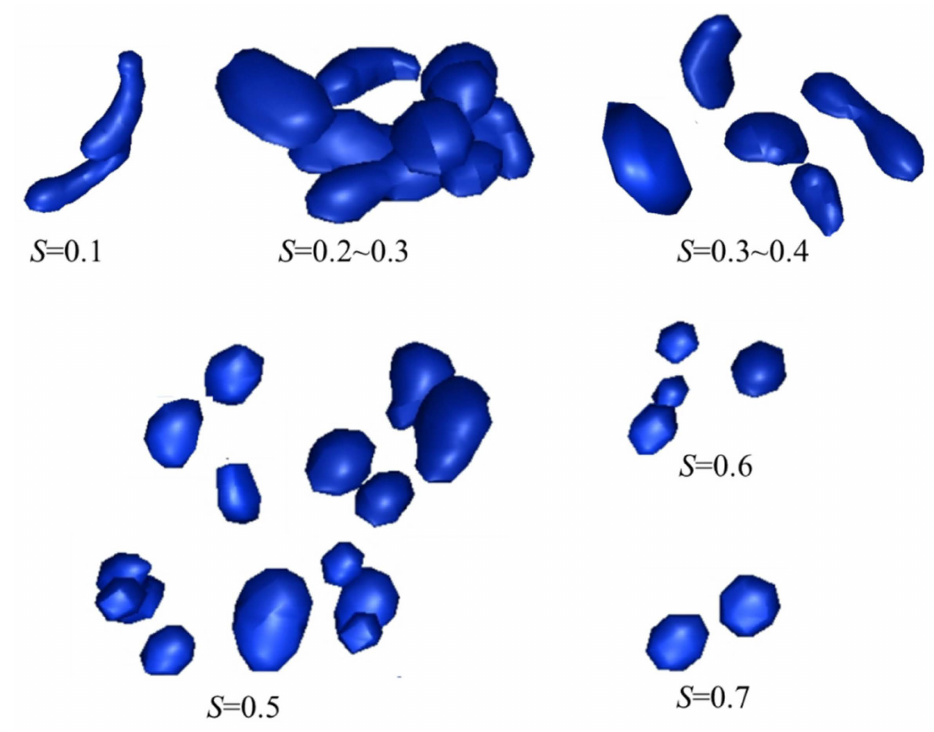
Figure 12. Droplets. ( p injection = 100 MPa, p b = 1 MPa).